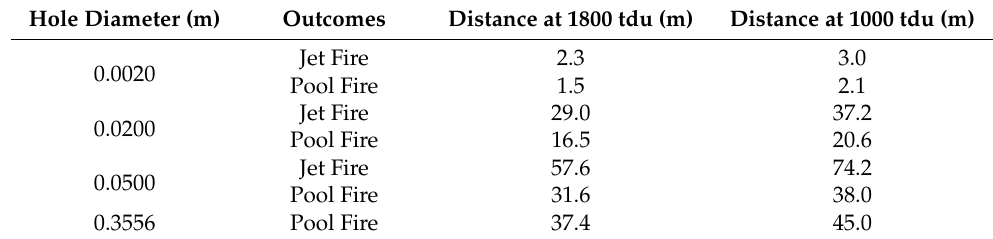
Table 8. Exposure distances to 1800 and 1000